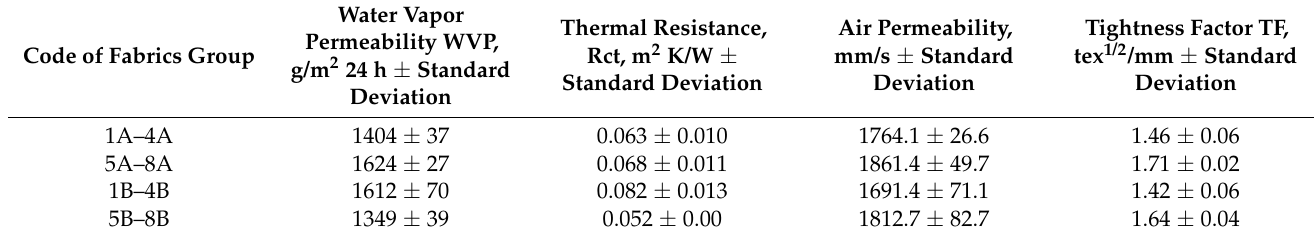
Table 7. Results of the parameters representing thermoregulatory properties.